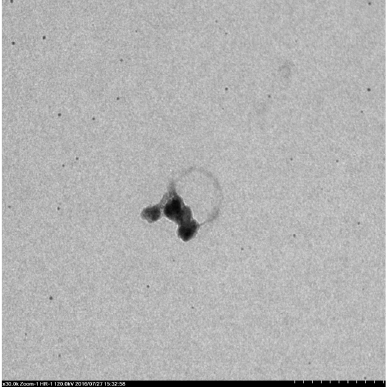
Figure 3. The TEM image of a UFB partly covered with a hydrophobic impurity (oleic acid). The diameter of the UFB is 105 nm. Reprinted with permission from Ref. [30]. Copyright 2017, the Japanese Society for Multiphase Flow.